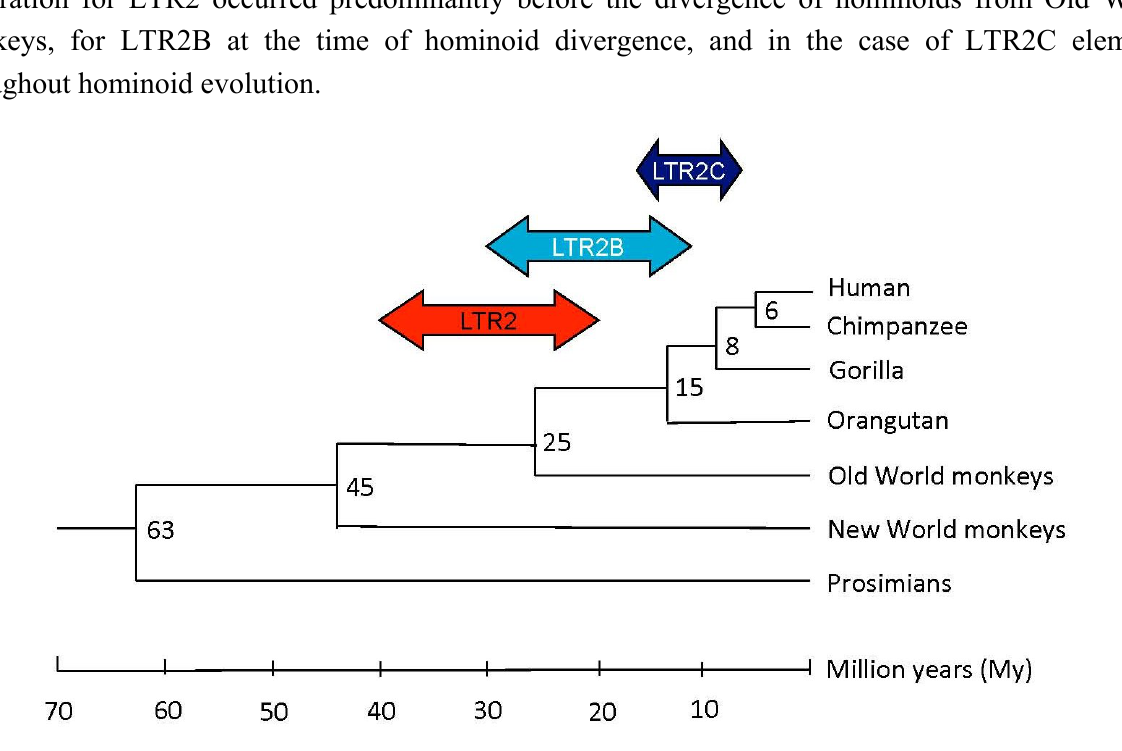
Figure 2. Putative integration times of the LTR2, LTR2B, LTR2C HERV-E familly members during primate evolution. The evolutionary tree was adapted from Yi et al .